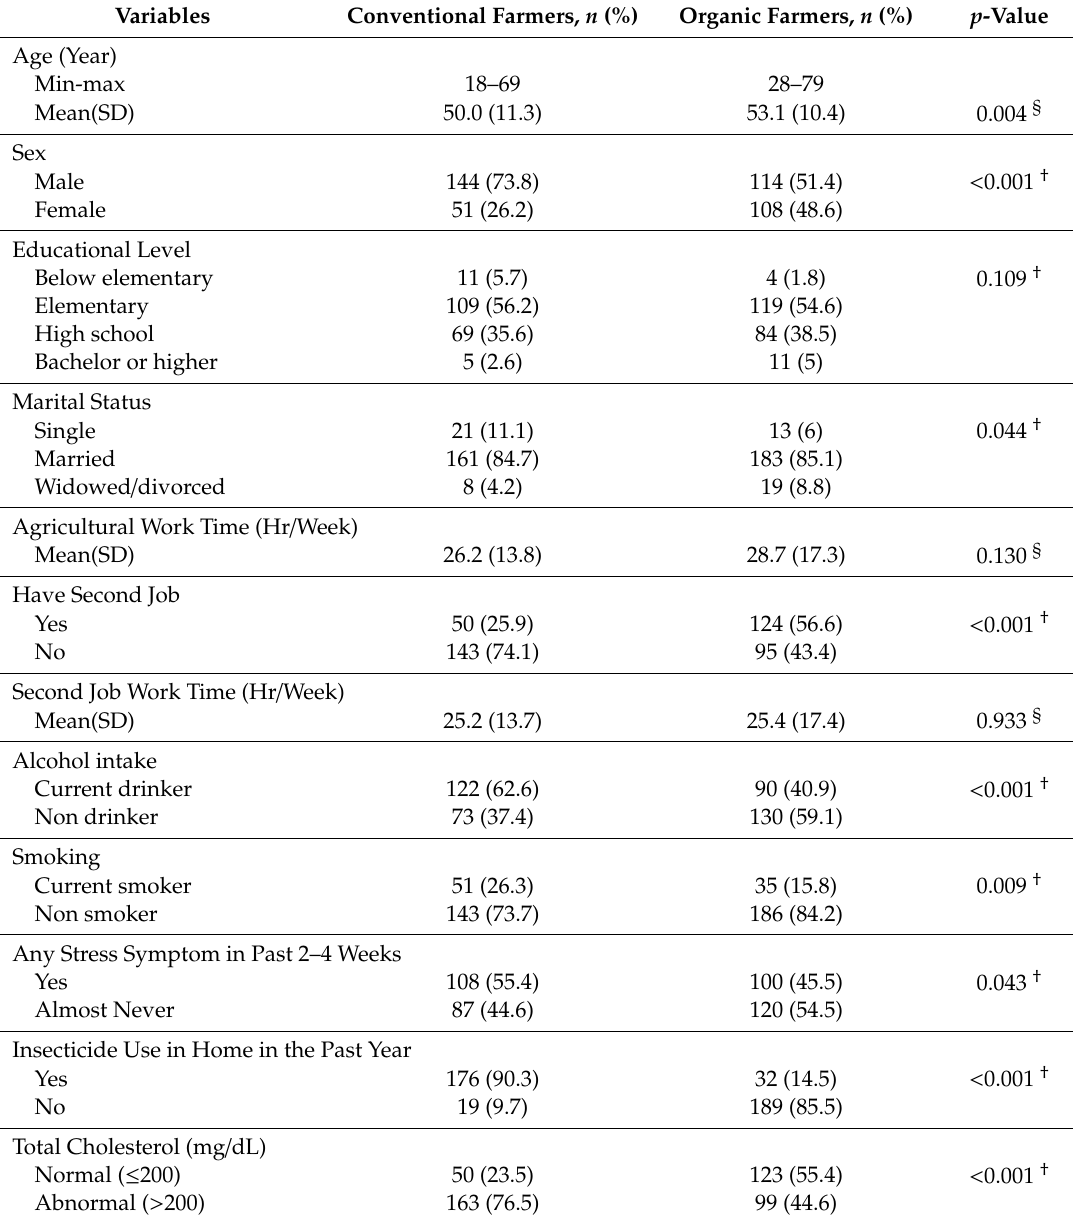
Table 1. Characteristic and risk factors of conventional farmers ( n = 195) and organic farmers ( n = 222). Variables Conventional Farmers, n (%) Organic Farmers, n (%) p